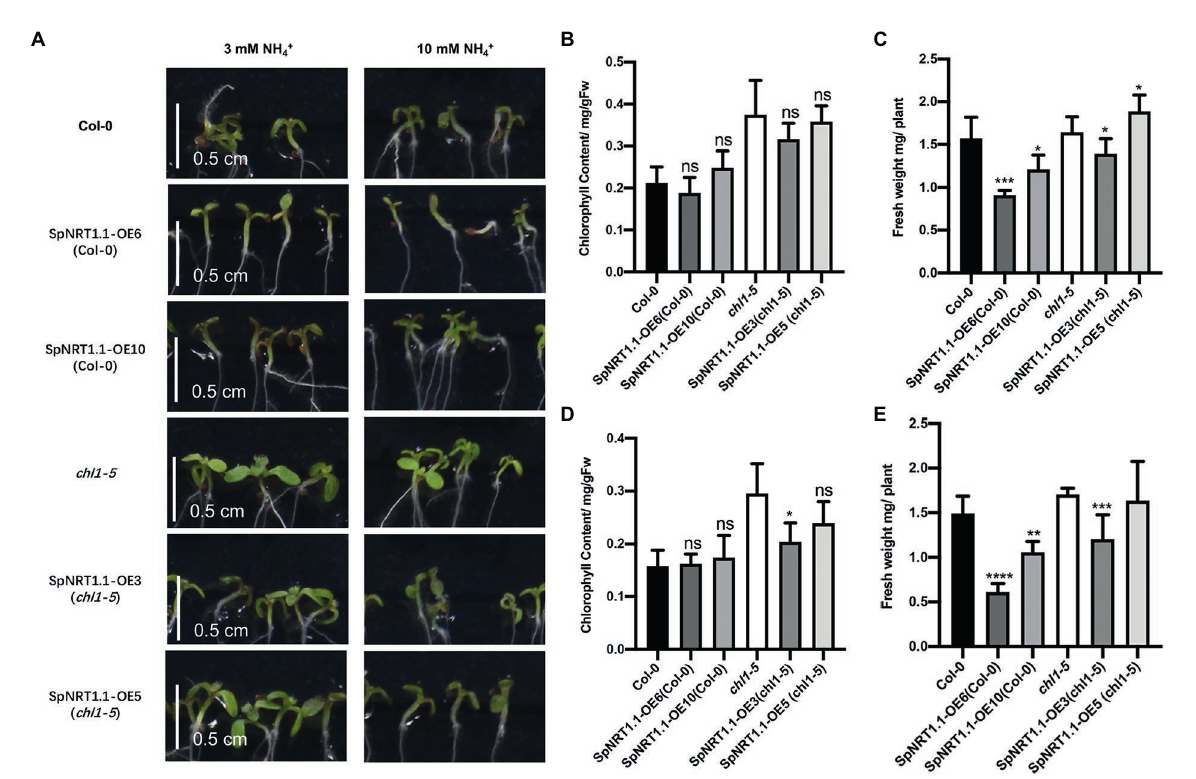
FIGURE 7 Overexpression of SpNRT1.1 in Col-0 and chl1-5 plants leads to sensitivity to ammonium. (A) Phenotype of SpNRT1.1 overexpressed and complemented plants under different ammonium concentrations. Chlorophyll content and fresh weight under 3 mm NH 4+ (B,C) and 10 mm NH 4+ (D,E) . Student’s t -test was used for significant difference analysis. Asterisks indicate significance levels compared with chl1-5 mutant plants, * p < 0.05, ** p < 0.01, *** p < 0.001, **** p < 0.0001, n ≥ 5, Scale bar = 0.5